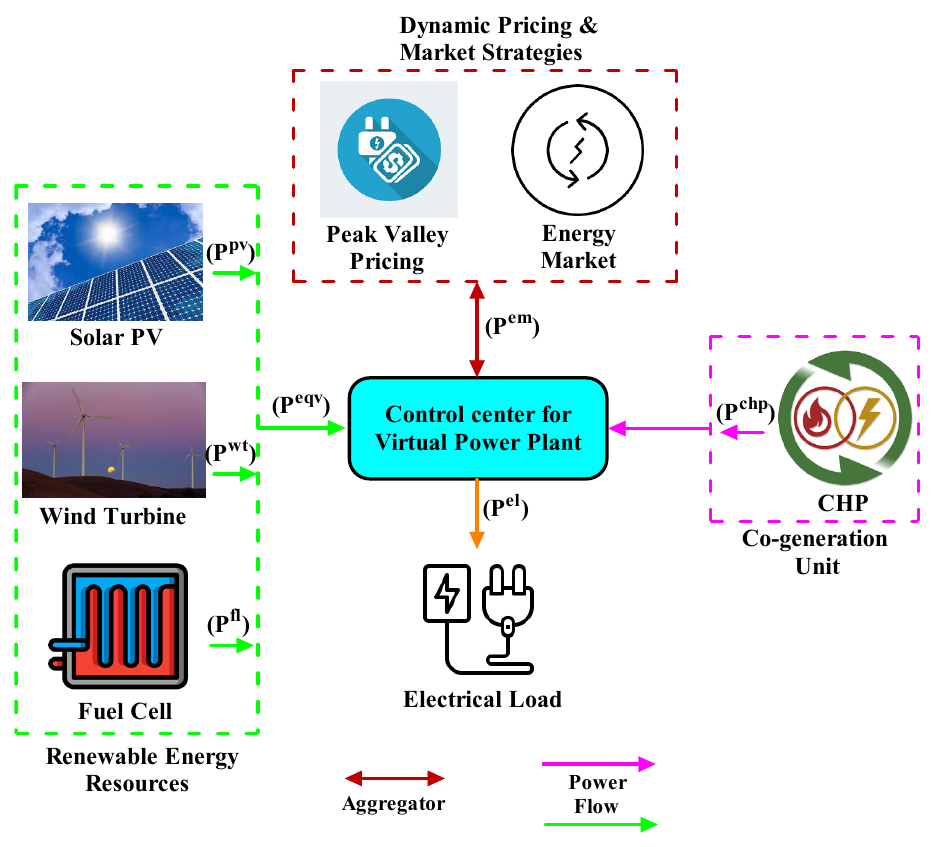
Figure 4. The proposed VPP system under study.